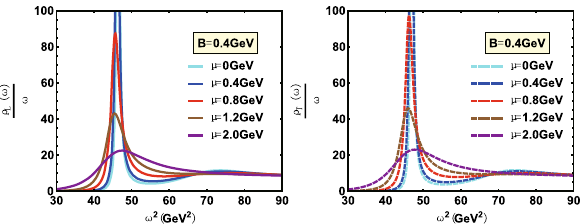
Fig. 9 Thespectralfunctionofthe ϒ( 1 S ) statewithdifferentchemical potential μ at T = 0 . 3GeV.Theleftpictureisformagneticfieldparallel to polarization and the right one is for magnetic field perpendicular to polarization